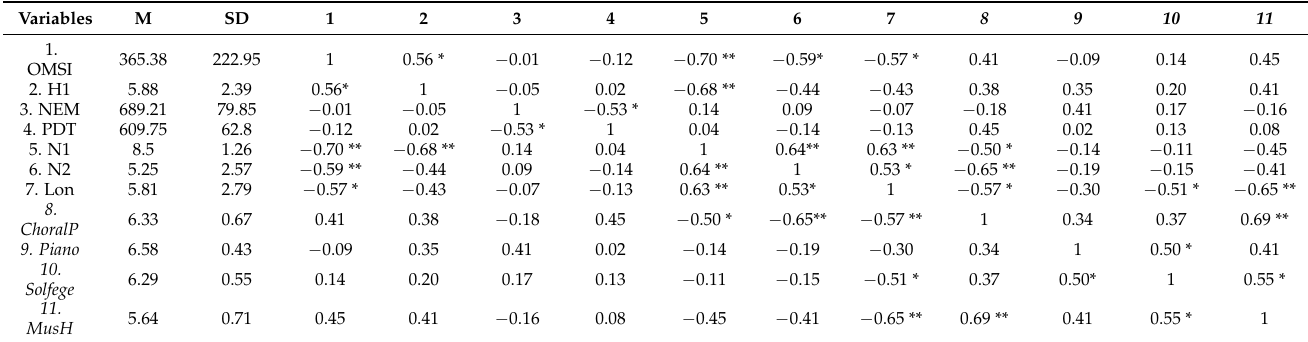
Table 2. Correlation